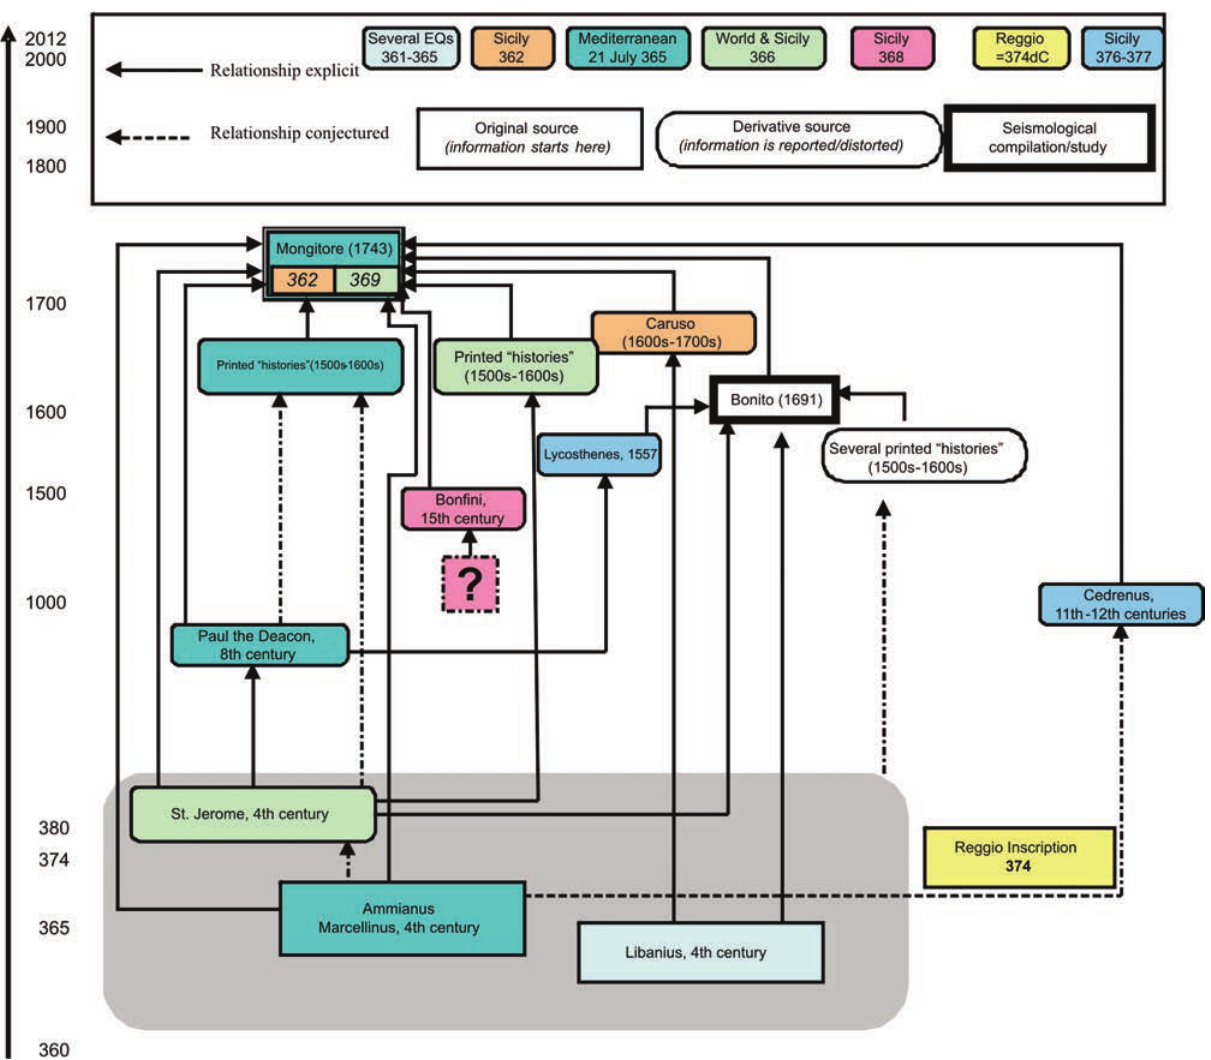
Figure 8. Flow chart of studies and sources revaluated in this study for the 4th century earthquakes.